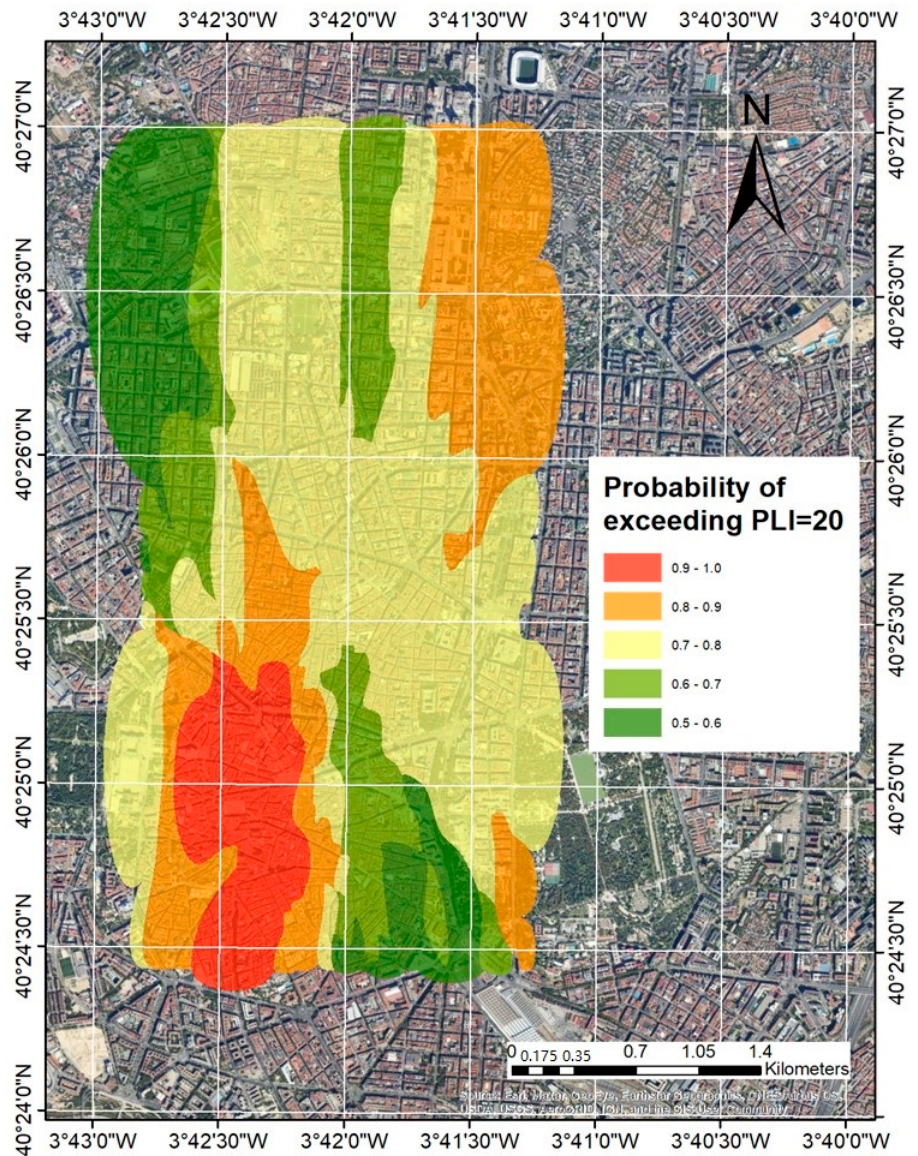
Figure 5. PLI spatial distribution map in the center of Madrid. The interpolation method was kriging indicator because it accepts data non ‐ normality (Gaussian distribution) and converts the estimated values into indicator values that rank from 0 to 1. The output is the probability range of exceeding a cut ‐ off value. We used a value of PLI = 20 as a cut ‐ off value.